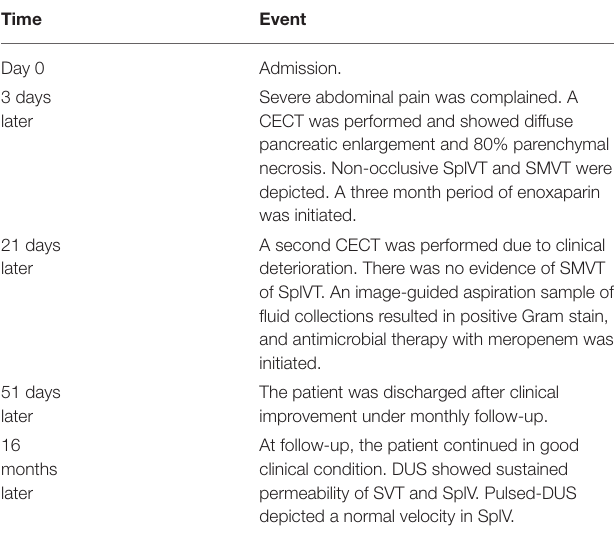
TABLE 1 | The timeline with relevant data from the episode of care.